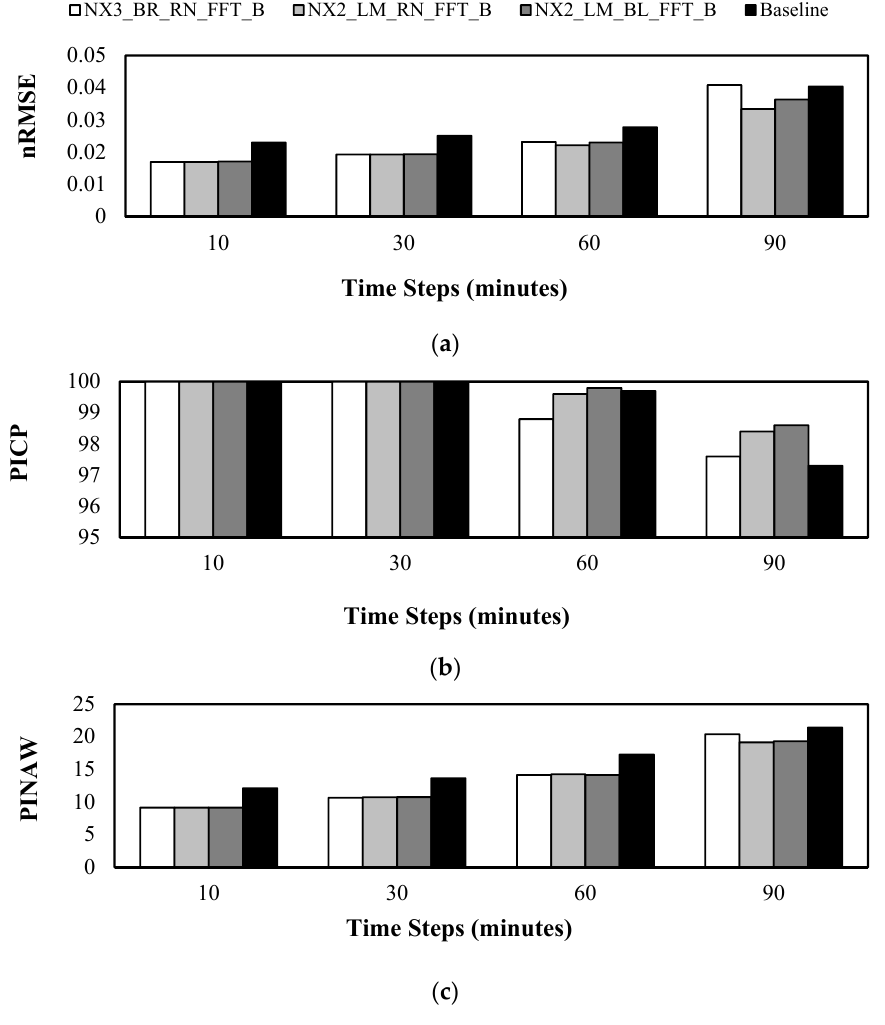
Figure 10. A comparison of the 3 best models to the baseline model proposed in [4] in terms of ( a ) nRMSE, ( b ) PICP, and ( c ) PINAW, at different time horizon (i.e., 10, 30, 60, and 90 min). Note that 500 samples were used; each of which is a 10 min interval. This results in a total of ~83 h.